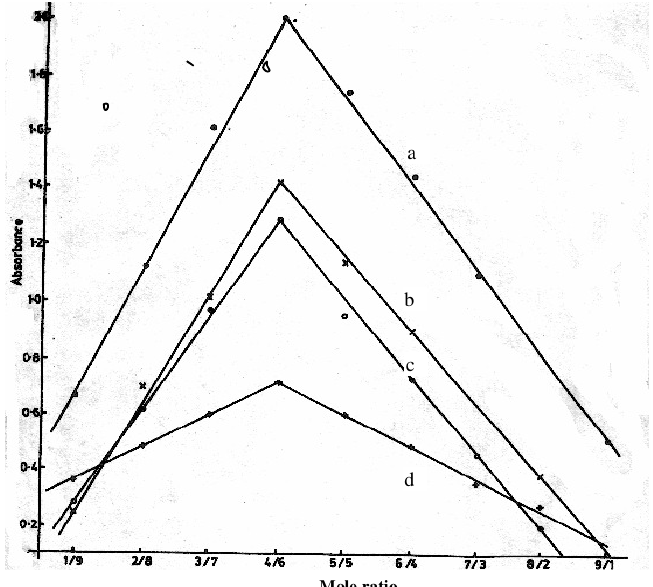
Figure 1. Jobs curve for Cu(II) – BHPDE complex. Metal ligand mole ratio = 2:3. (a) 0.001M HCl; (b) 0.001M HNO